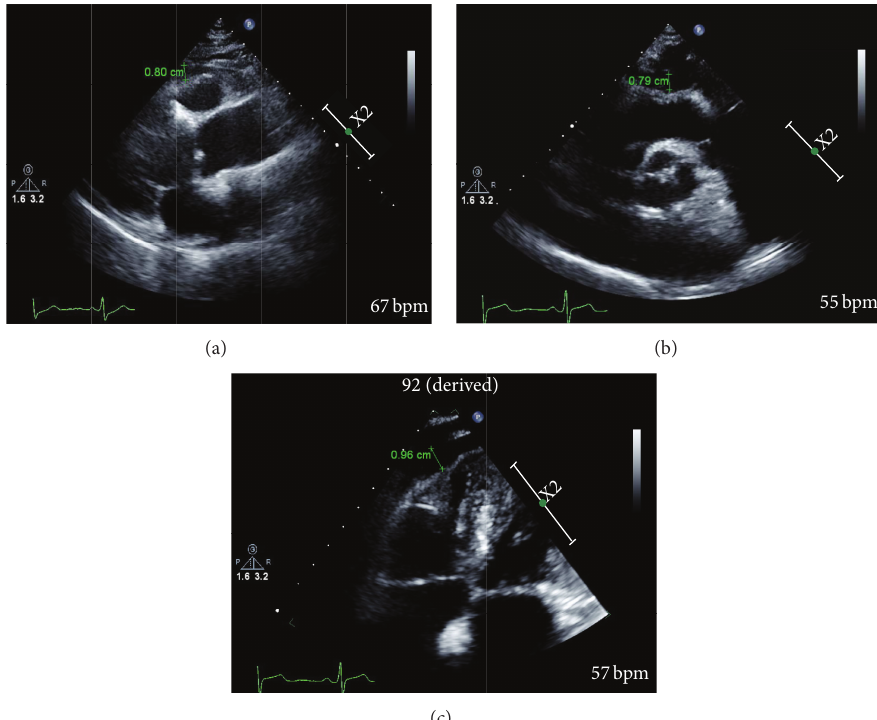
Figure 1: Measurement of epicardial fat thickness (EFT, green arrows) by echocardiography. (a) The maximum EFT was measured perpendicularly from the free wall of the right ventricle at end-systole from the parasternal long axis. (b) Maximum EFT was measured from the point on the free wall of the right ventricle along the midline of the ultrasound beam perpendicular to the aortic annulus as the anatomic landmark. (c) Maximum EFT was measured from the apical 4-chamber focused on the right ventricle echocardiographic